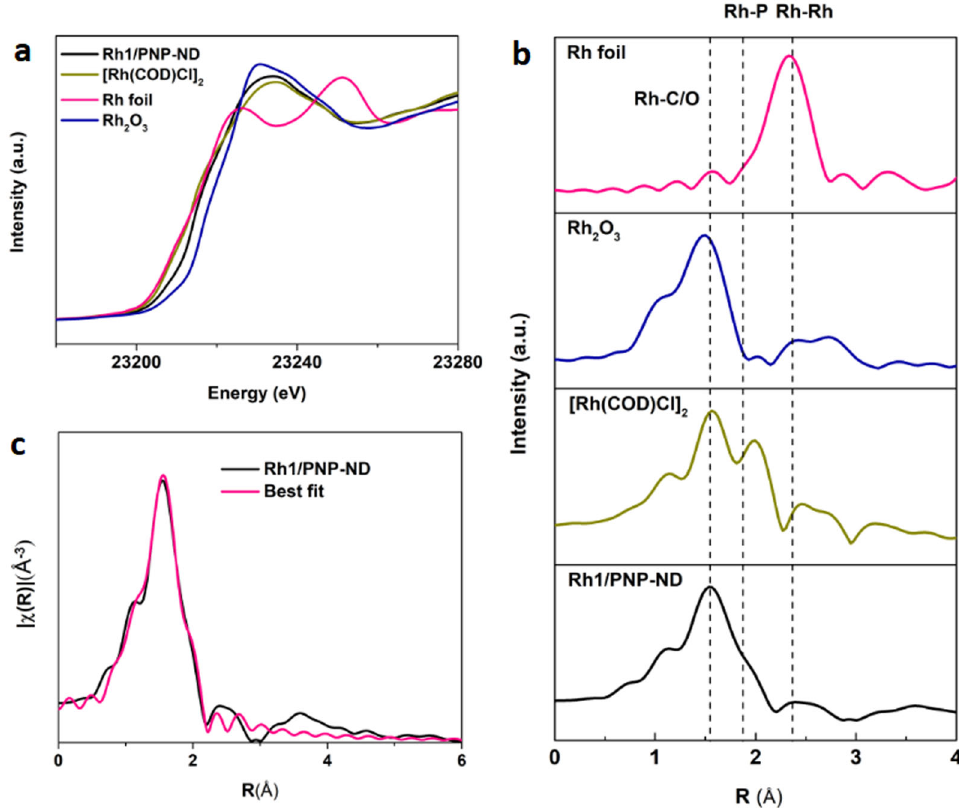
Fig. 4 The Rh XAS data of Rh1/PNP-ND and standard Rh materials. a The normalized XANES spectra at the Rh K-edge of the Rh 1 /PNP-ND, [Rh(COD) Cl] 2 , Rh 2 O 3 , and Rh foil. b The Fourier transform of k 2 -weighted EXAFS spectra at the K-edge of the Rh1/PNP-ND, [Rh(COD)Cl] 2 , Rh 2 O 3 , and Rh foil. . c The experimental Rh EXAFS spectra (black line) and the fi tting curve of Rh 1 /PNP-ND (red